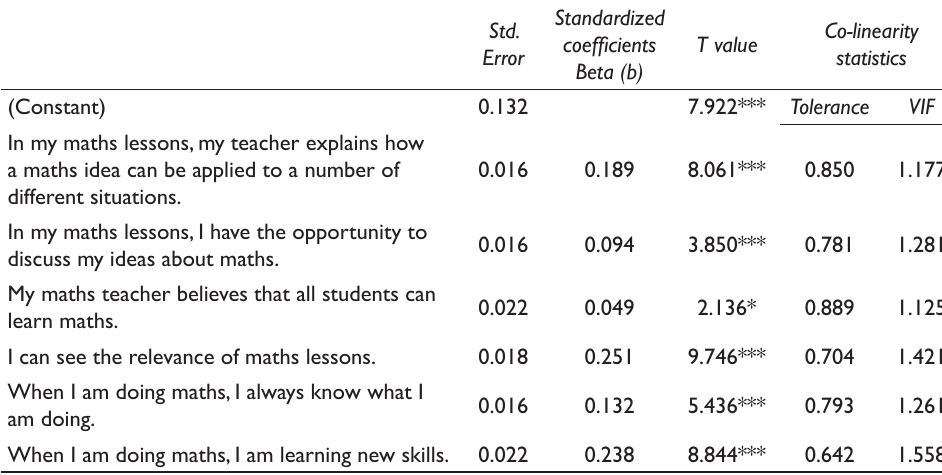
Table 7: OLS regression estimates of factors that are associated with London secondary school students’ intrinsic motivation